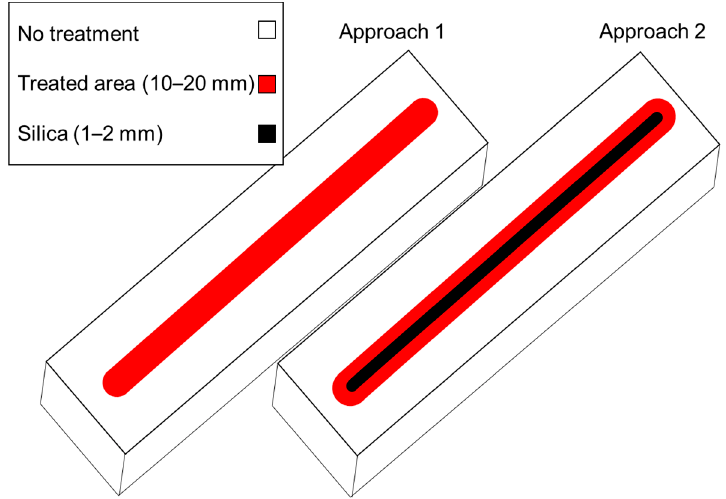
Figure 2. The two different approaches to selective bonding. Dimensions of each region depend on the exposure level.